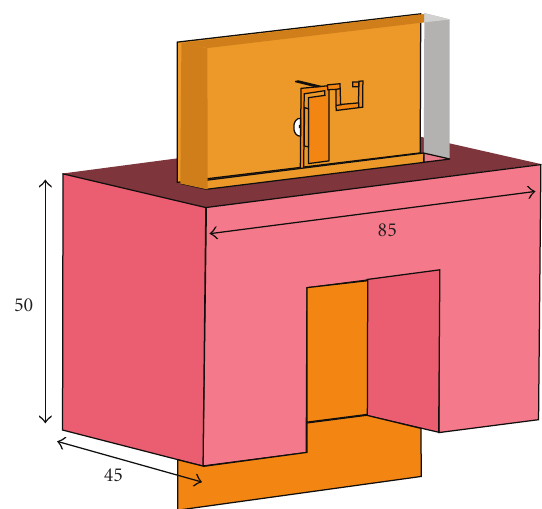
Figure 12: General view of the tri-band antenna with the proposed hand model.